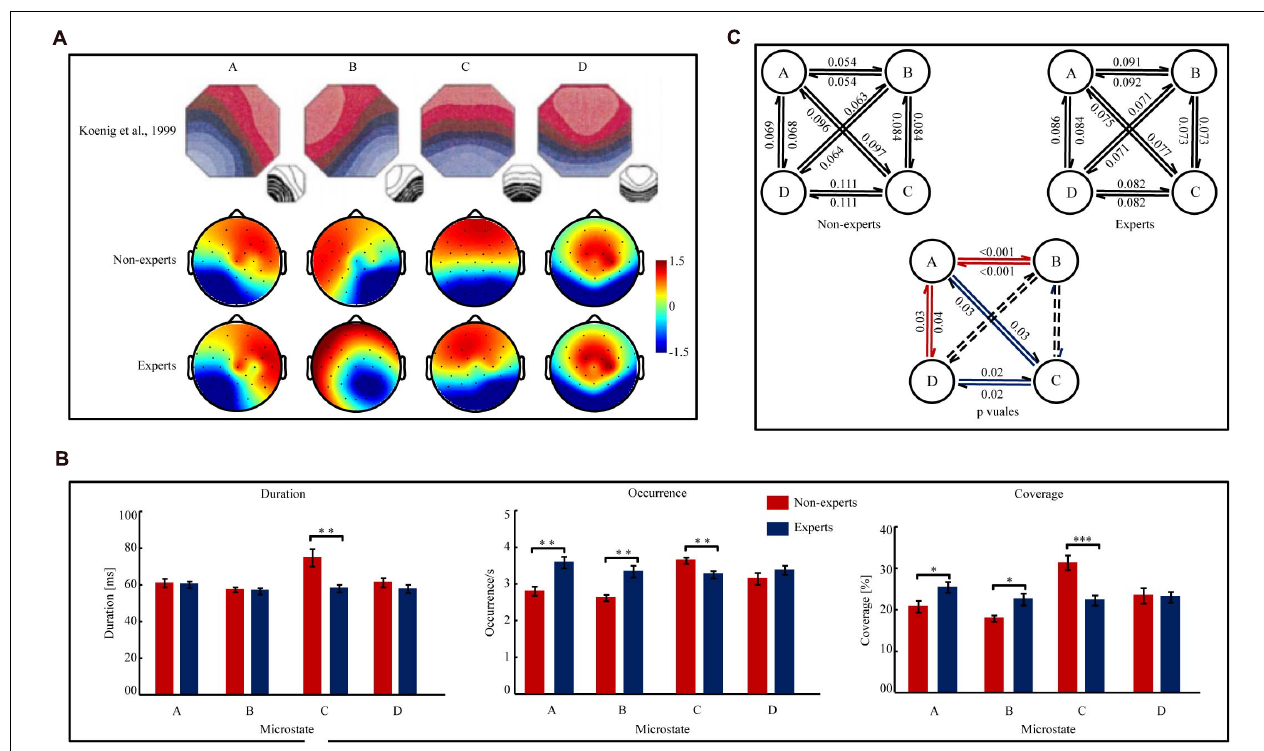
FIGURE 3 | The map topographies of microstate A, B, C, and D and the parameters of the temporal complexity in Player Unknown’s Battle Grounds (PUBG) non-experts and experts. (A) The map topographies of microstate A, B, C, and D of control group reported in Koenig et al. (1999) and PUBG non-experts and experts. Microstate A exhibits a left-right orientation, microstate B exhibits a right-left orientation, microstate C exhibits an anterior-posterior orientation, and microstate D exhibits a fronto-central maximum. The color bar of topographies ranges from –1.5 µ V to 1.5 µ v and the values indicate the average potential of global field potential (GFP). Red color indicates positive values and blue color indicates negative values (can be inverted). (B) The Mean duration, Occurrence, and Coverage of microstate A, B, C, and D in PUBG non-experts and experts. Error bars represent Mean ± S.E.M. ∗ p [ FDR ] < 0.05, ∗∗ p [ FDR ] < 0.01, ∗∗∗ p [ FDR ] < 0.001. (C) Figure 1C (the two figures in upper part of Figure 1C ) indicated the transition probabilities from one microstate to other microstate for all four microstates in PUBG non-experts and experts. The arrow indicated the transition direction from a given microstate to other one. The value on the arrow indicated the transition probabilities. Figure 1C (the one figure in the lower part of Figure 1C ) indicated the difference of the transition probabilities between PUBG non-experts and experts. The value on the arrow indicated the significant p [ FDR ] values of the transition probabilities between PUBG non-experts and experts. The red arrow indicated PUBG experts had higher transition probabilities than non-experts. While the blue arrow indicated PUBG experts had lower transition probabilities than non-experts. The dashed lines indicated transition probability did not significantly differ was not significant between